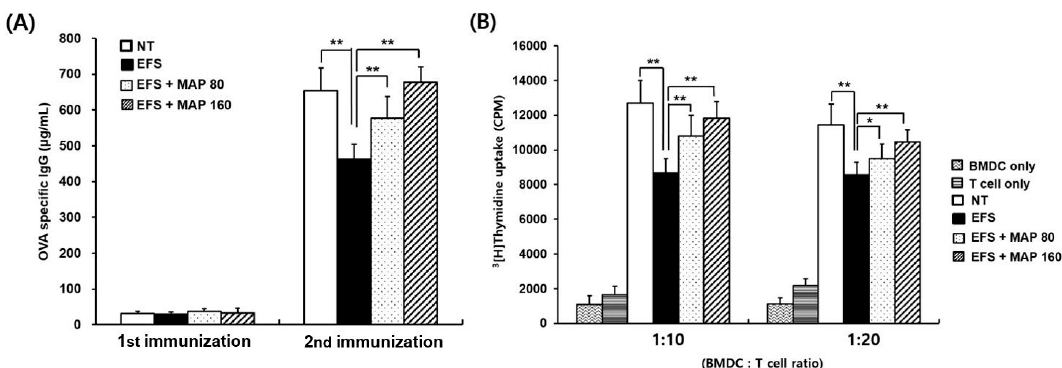
Figure 5. Immune enhancing effect of MAP on OVA-specific IgG production and OVA-specific T cell generation in chronically stressed mice. Mice are grouped as described in Figure 1. Immunization of OVA peptide was achieved in mice. Serum lgG levels of collected blood were monitored using ELISA analysis ( A ); Isolated T cells from OVA-immunized mice and OVA-pulsed bone marrow-derived cells (BMDCs) were co-cultured and DNA synthesis of T cells was measured using 3 (H)-thymidine incorporation. T cells only, T cells from NT group, and BMDCs only, OVA-pulsed BMDCs were also separately cultured ( B ). Values are means ± SEM of three experiments, n = 5, * p < 0.05, ** p < 0.01